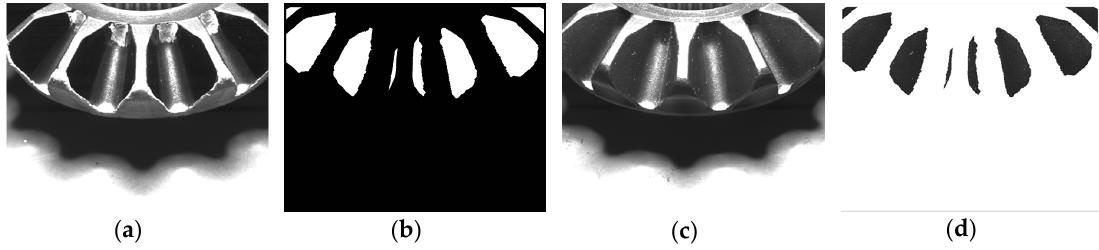
Figure 16. The collection and use of bevel gear lateral template. ( a ) Lateral image of template gear; ( b ) Extracted template; ( c ) Lateral image to be detected; ( d ) Extracted image by template matching.